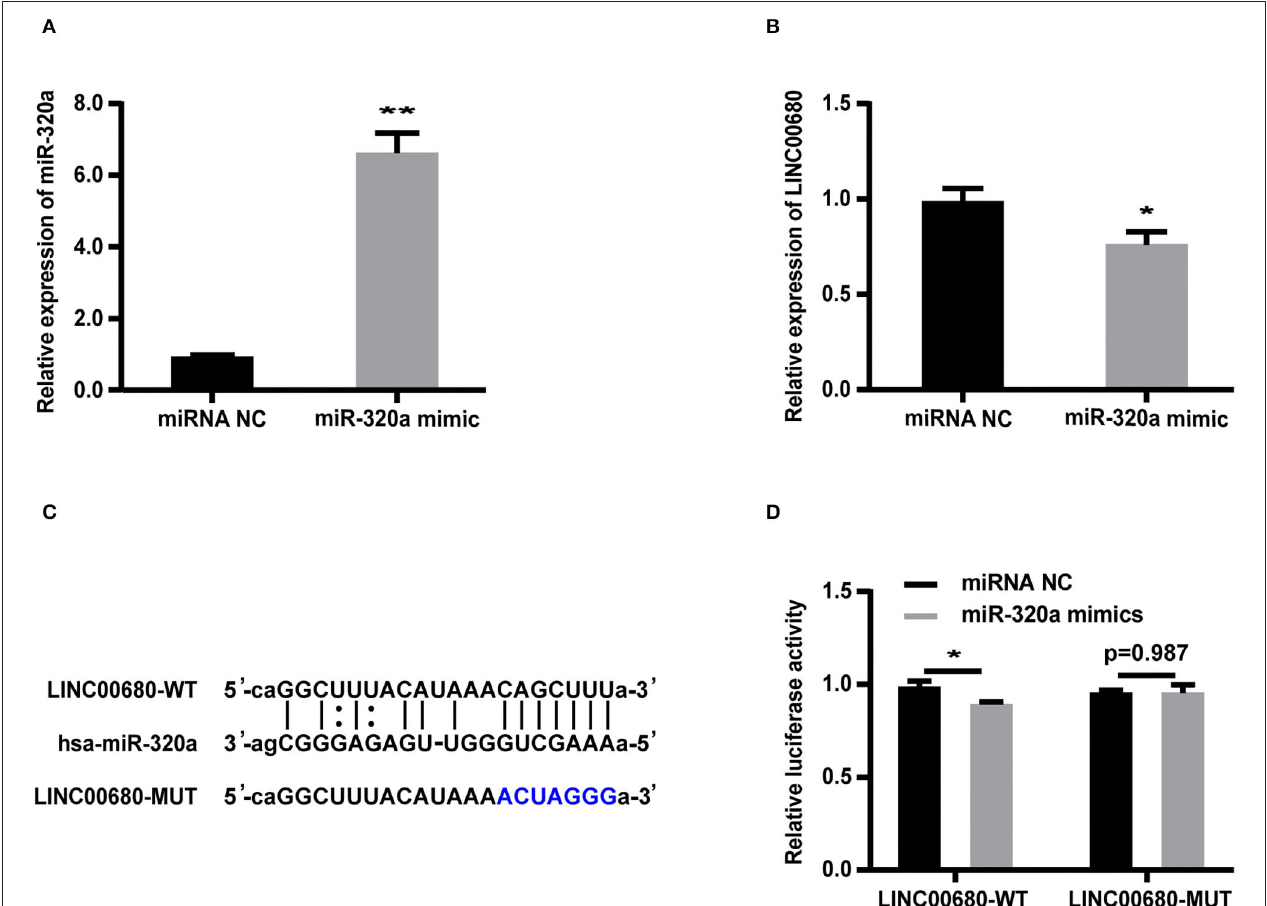
FIGURE 3 | LINC00680 is a target of miR-320a. (A) The transfection efficiency of the miR-320a mimic was detected by real-time PCR (B) The relative expression levels of LINC00680 transfected with miRNA NC or the miR-320a mimic in Jurkat cells for 48h were detected by real-time PCR (C) The putative miR-320a binding sequence of the wild-type and mutated sequence of LINC00680 (D) A luciferase reporter plasmid containing LINC00680-WT or LINC00680-MUT was co-transfected with the miR-320a mimic or miRNA NC into HEK293T cells for 48h. Luciferase activities were calculated as the ratio of Firefly/Renilla activities (* p < 0.05, ** p < 0.01).